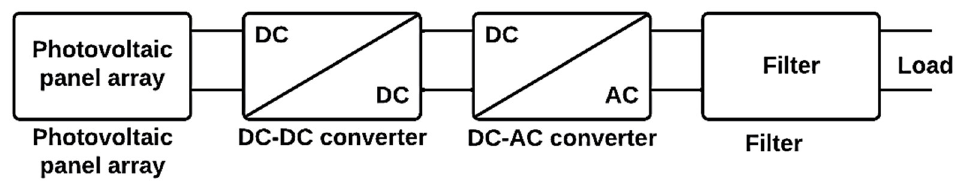
Figure 1. Diagram of the main elements of a photovoltaic system.